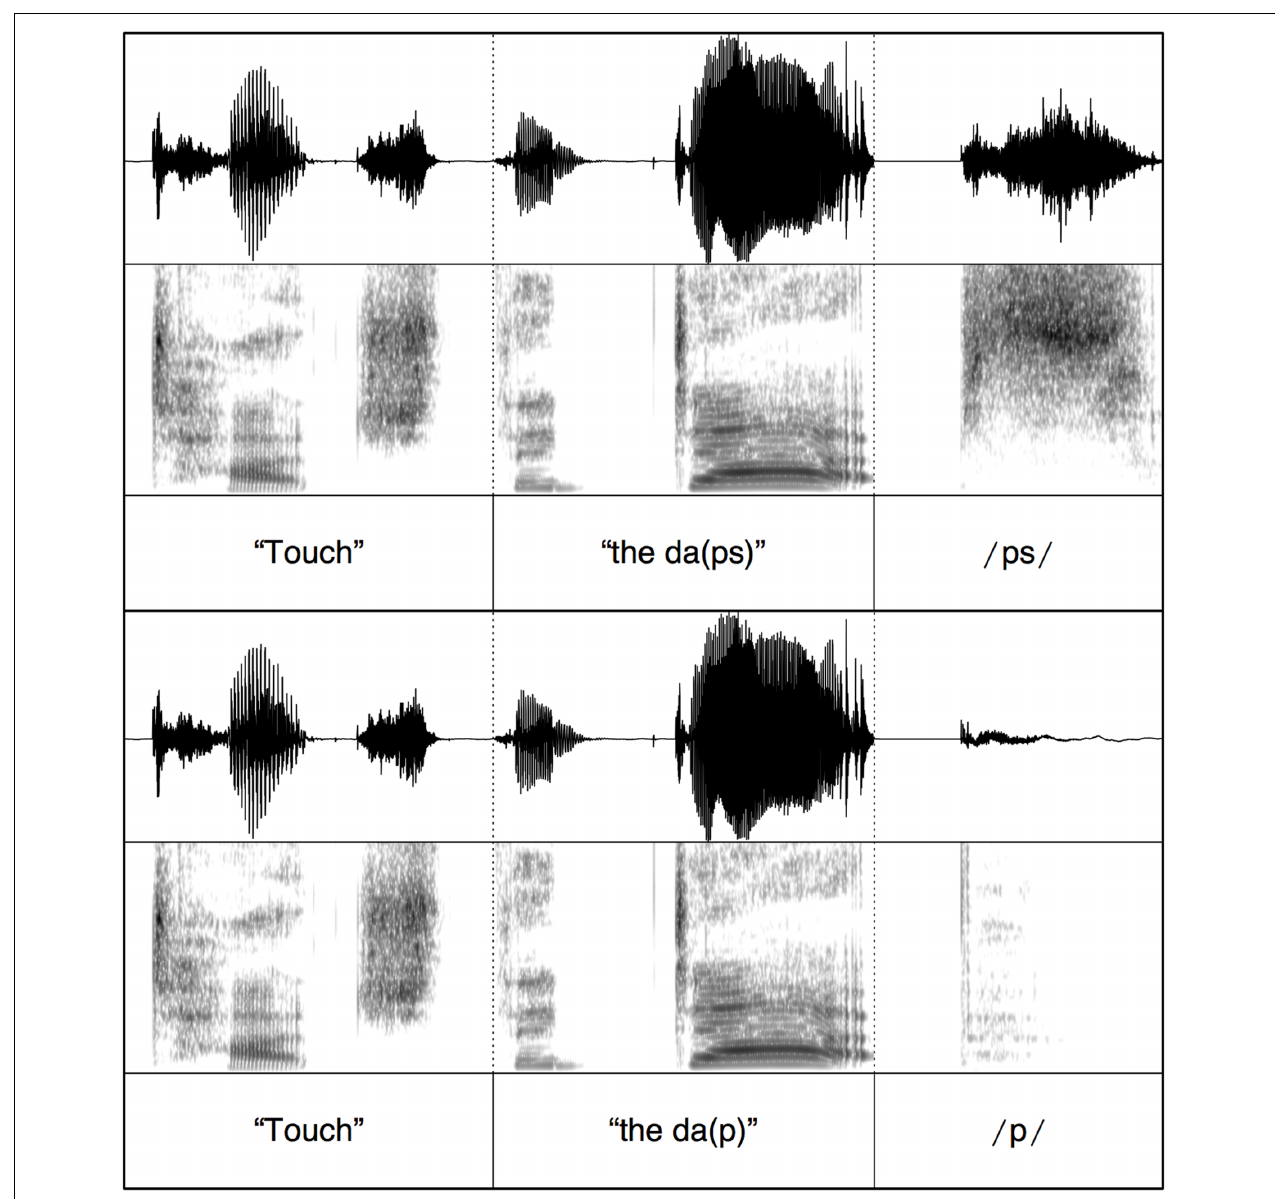
FIGURE 2 | Example stimulus splicing for auditory stimuli with segmental morpheme